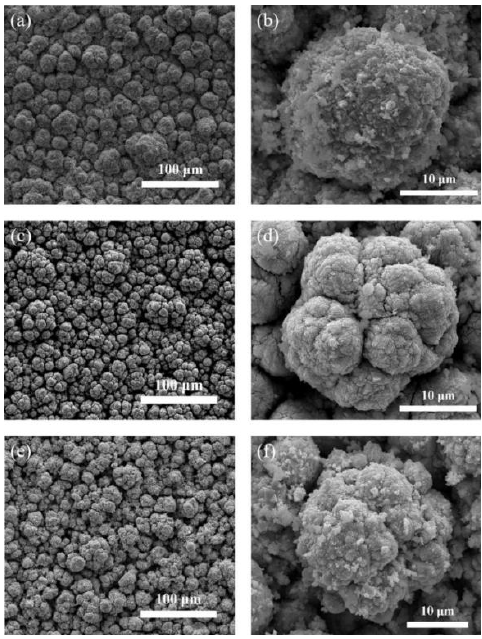
Figure 3. Surface morphologies of corresponding LC coatings: ( a ) Coating 1, ( b ) Coating 1 (magnified); ( c ) Coating 2, ( d ) Coating 2 (magnified); ( e ) Coating 3, ( f ) Coating 3 (magnified).